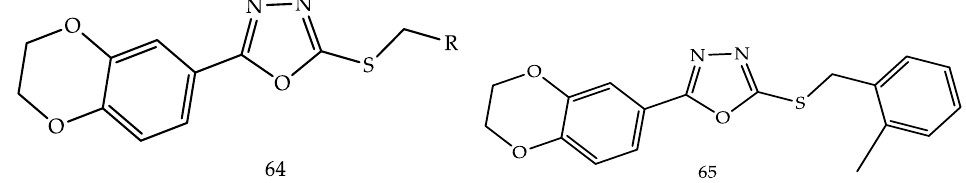
Figure 13. Chemical structures of 1,4-benzodioxan moiety containing 1,3,4-oxadiazole derivatives.